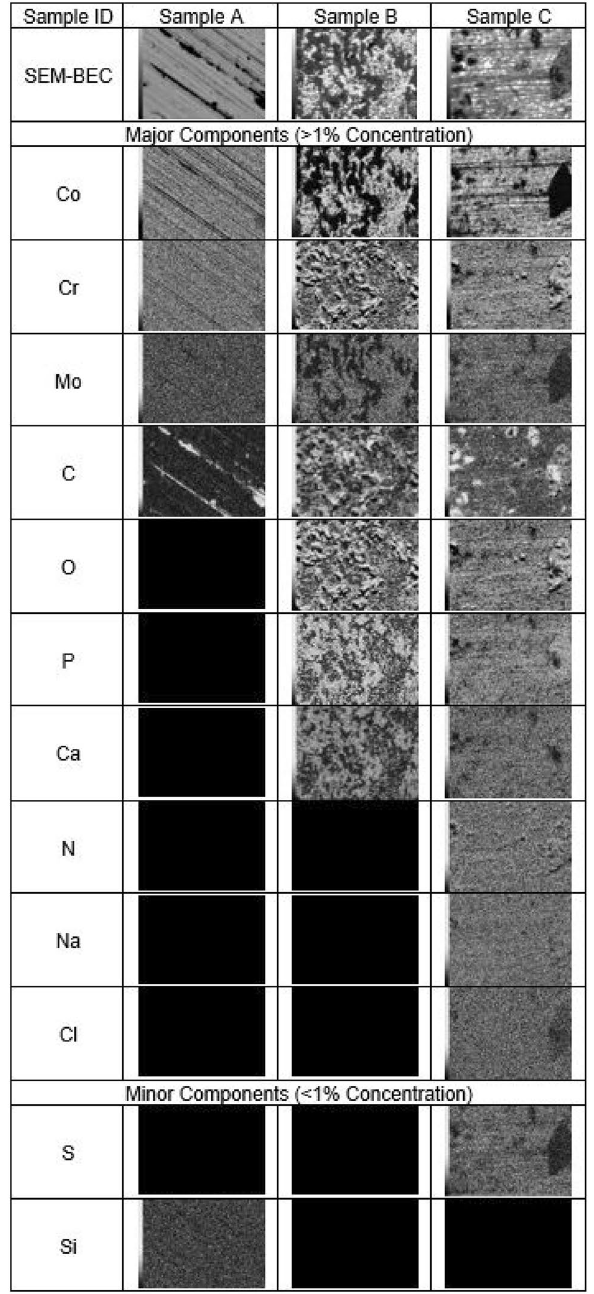
Figure 3. EDS analysis and back scatter electron composite images. Grayscale mapping of surface elemental compositions with back scatter images shown in the first row. Darker shades represent lower concentrations of the specified element, whereas lighter shades indicate higher concentrations of the specified element. Sample A, shielded from electrical activity, shows little elemental change from the base alloy. Sample A contains Co, Cr, Mo, C and traces of Si. Sample B, subjected to a 50 MHz, 200 mVpp sine wave, shows significant surface modification. Sample B contains Co, Cr, Mo, C, O, P, and Ca. Sample C, subjected to a 25 MHz, 200 mVpp square wave, shows the greatest variation in elemental composition. Sample C contains Co, Cr, Mo, C, O, P, Ca, N, Na, Cl, and